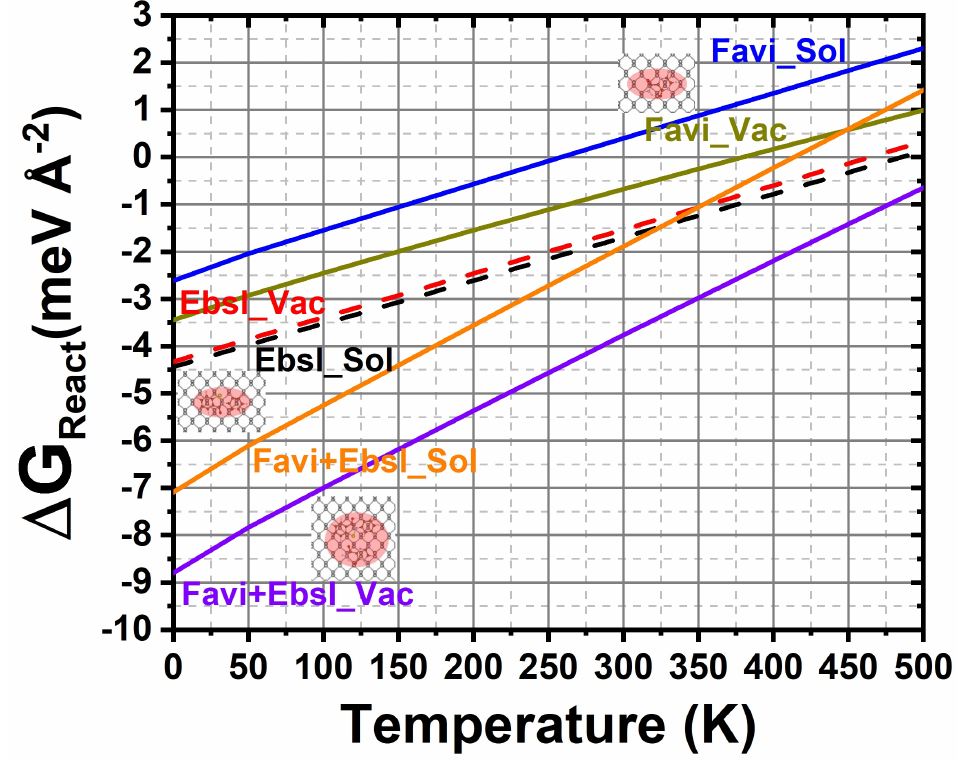
Figure 8. The free Gibbs energy process as a function of temperature in the vacuum and solvent phases of BP sheet with respect to favipiravir, ebselen, and favipiravir+ebselen hybrid